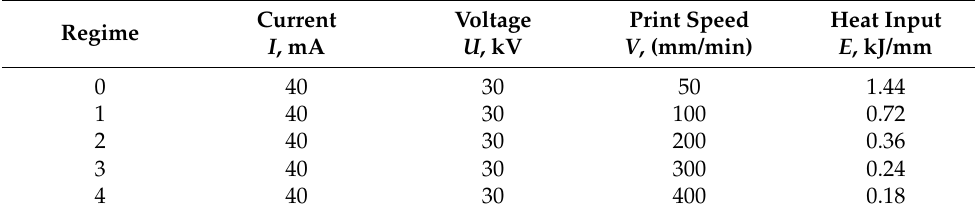
Table 2. Selected parameters of the printing